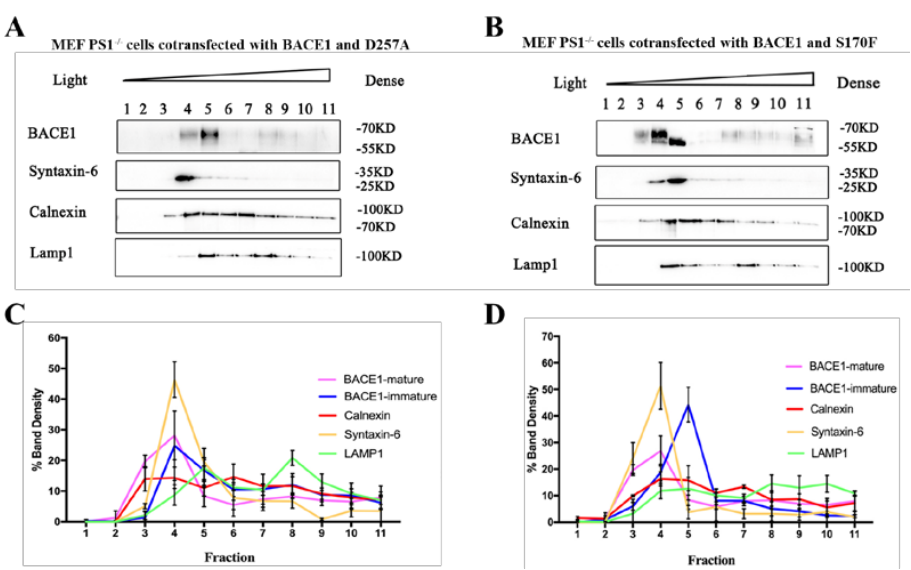
Figure 6. The effect of PS1 mutations on BACE1 subcellular fractionation in MEF PS1 −/− cell. Western blotting of samples after sucrose density gradient centrifugation with transient cotransfection of pBACE1 and pPS1-D257A ( A ) or pPS1-S170F ( B ). Their quantitative analyses are shown in ( C ) and ( D ), respectively. The Y-axis represents the percentage of target protein in one fraction against total fractions ( n = 3).